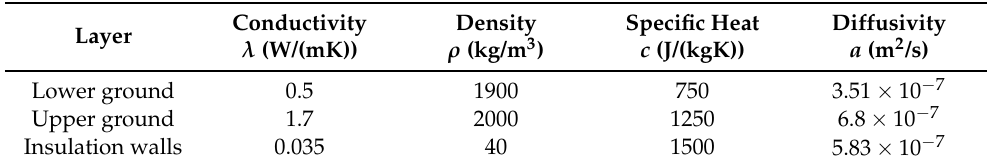
Figure 10. Position of the temperature probes B1–B9 of the 3D test field. Left: Plan view of the GES ( rectangular shape) and the installation location of the temperature probes B1–B9 ( hexagons ). Right: Cross-section of the 3D-GES and installation height of the temperature probes B1–B9. Each probe has several measuring points ( blue dots on black vertical lines) at different installation heights. In particular, the measuring points do not always have the same installation height, as indicated by the magenta horizontal lines. Table 4. Thermophysical properties of the materials involved for the real-world data scenario from the present test field.